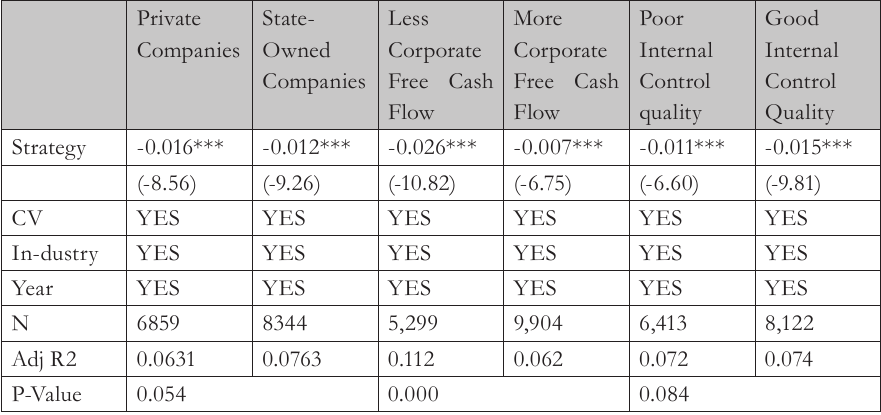
Tab. 7 – The influence of ownership, free cash flow and internal control. Source: own